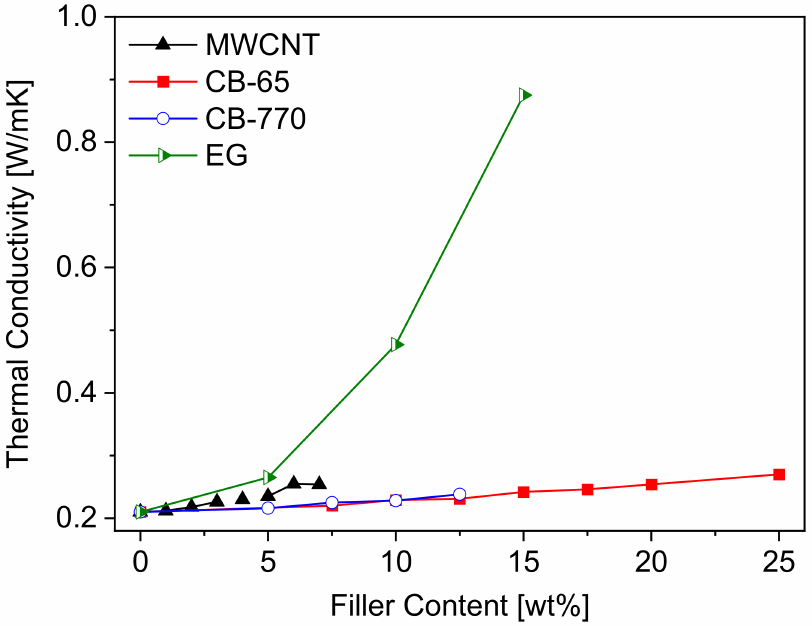
Figure 6. Thermal conductivity of carbon-based nanocomposites at different additives